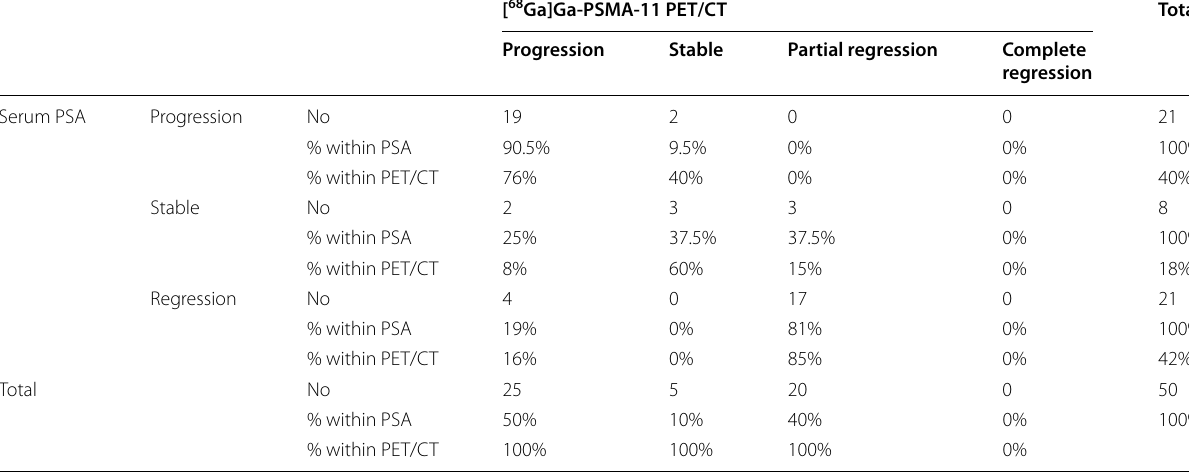
Table 3 Comparison of the results of serum PSA and [ 68 Ga]Ga-PSMA-11 PET/CT after therapy